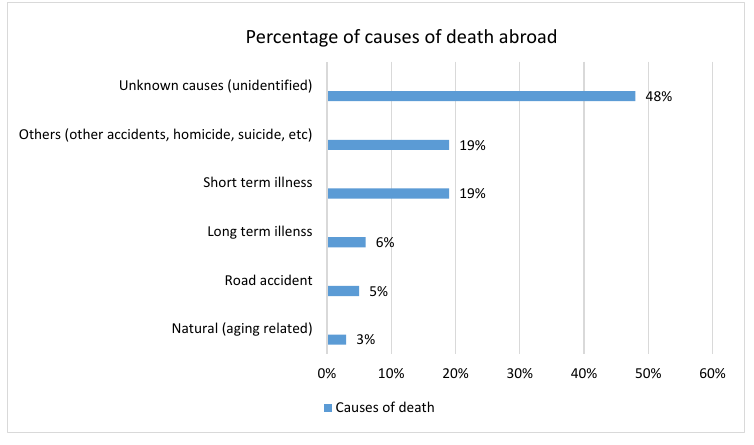
Figure 1. Causes of Death of Irish Travelers Abroad.